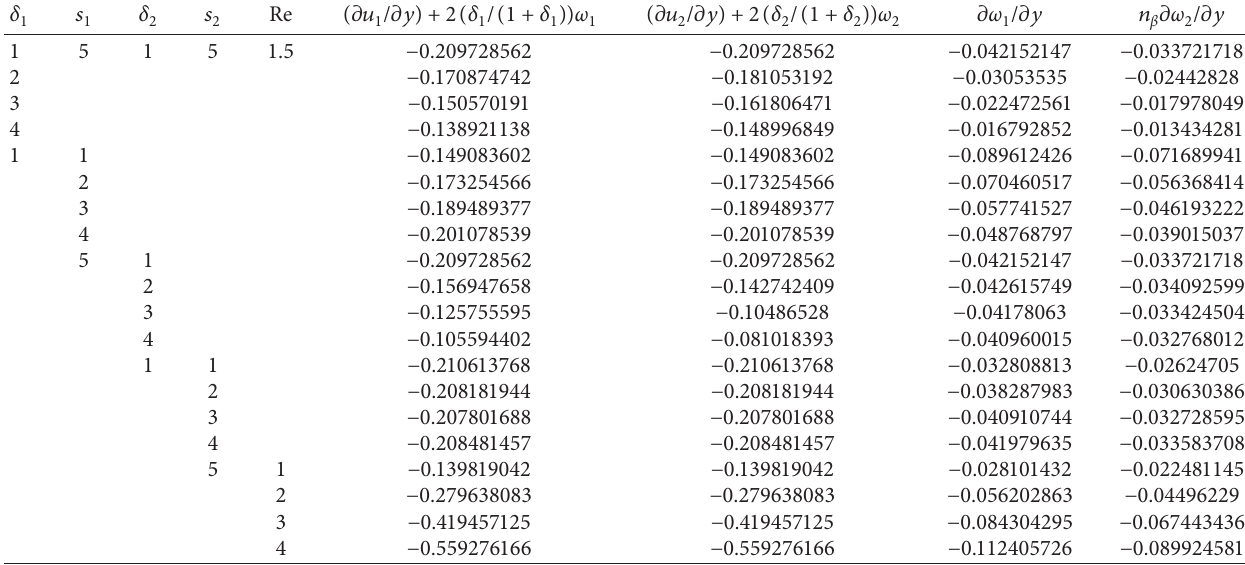
Table 1: Rate of shear stress coefficients and the couple stress coefficients at the fluid interfaces.